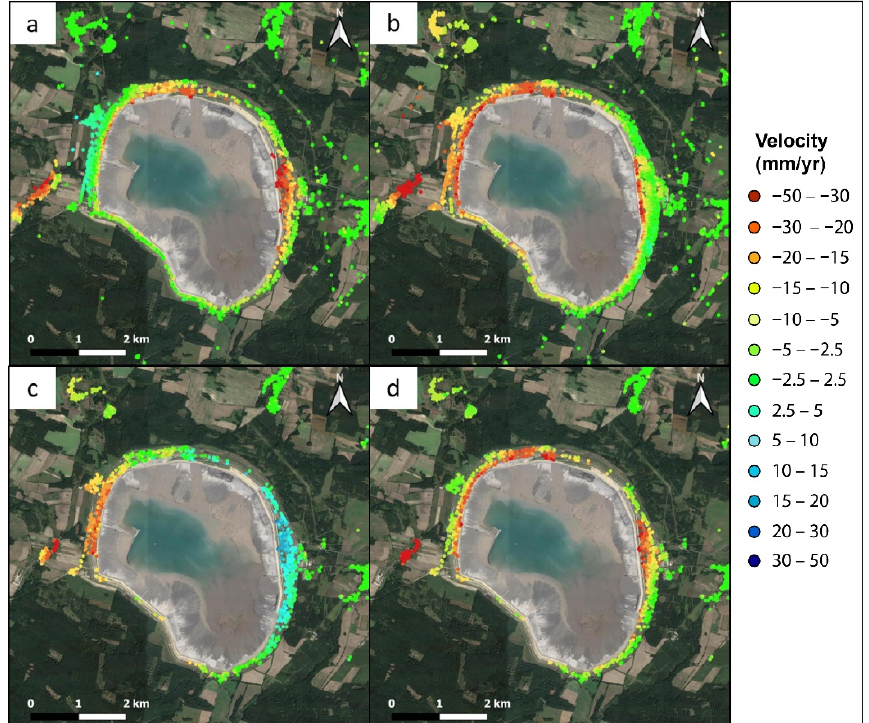
Figure 4. A-DInSAR velocity of displacement maps (mm/yr) of the Ż elazny Most tailings dam for the period October 2014–April 2019; ( a , b ) velocity in LOS ascending and descending orbital geometry respectively; green PSs are considered as stable; yellow-red PSs are moving away from the satellite; cyan-blue PSs are moving toward the satellite; ( c ) velocity in east-west direction; cyan-blue PSs are moving eastwards; yellow-red PSs are moving westwards; ( d ) velocity in up-down direction; yellow-red PSs are moving downward.